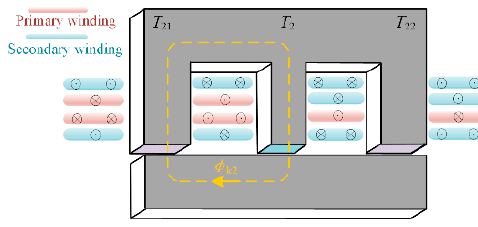
Figure 7. Integration scheme of T 2 .